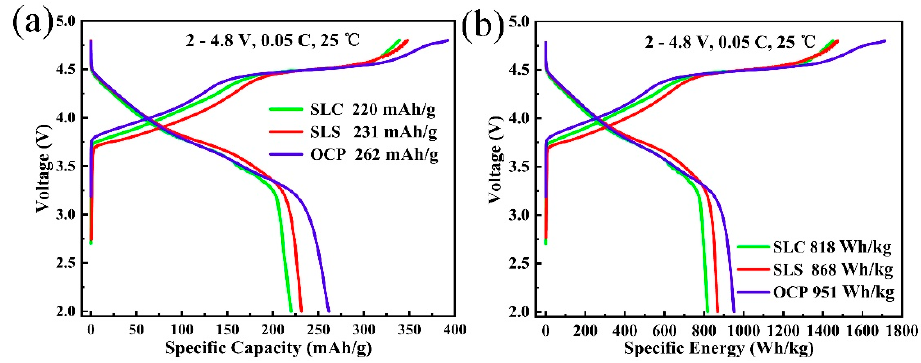
Figure 5. Initial charge and discharge curves of LL-811 samples prepared by different methods: ( a ) specific capacity; ( b ) specific energy.